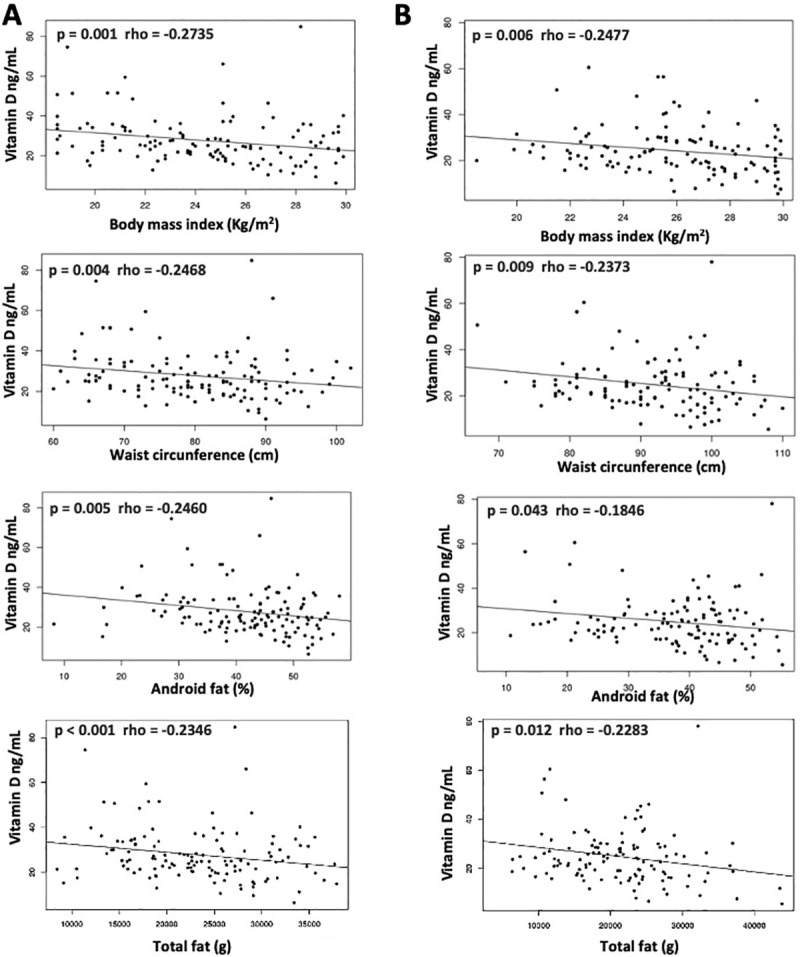
Correlation between vitamin D levels with body mass index (BMI), waist circumference, android fat, and total fat in women (A) and men (B).